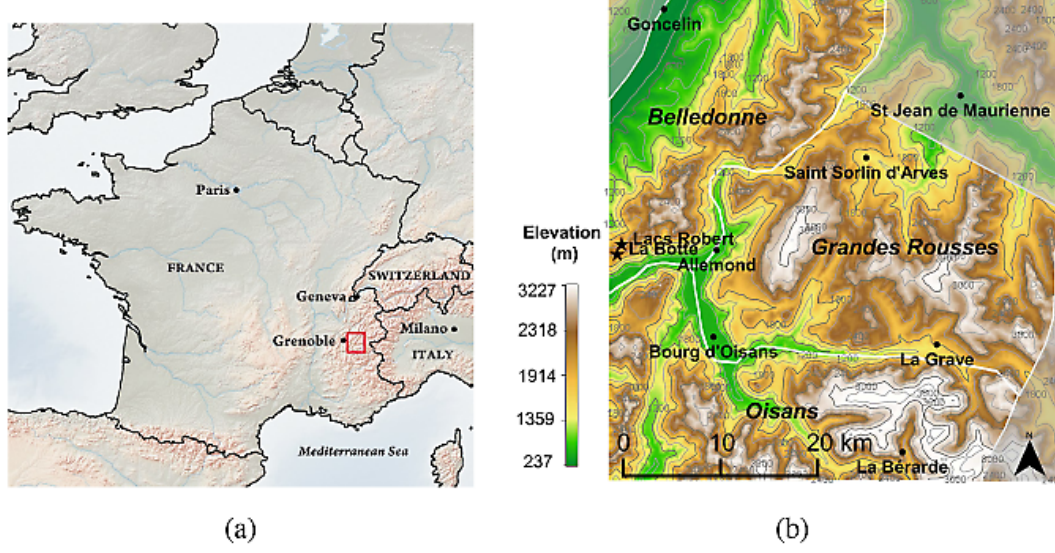
Fig. 1. (a) Geographical location of the studied domain (small red rectangle). (b) Elevation from SRTM DEM on the studied domain. Stars show locations of field measurements.